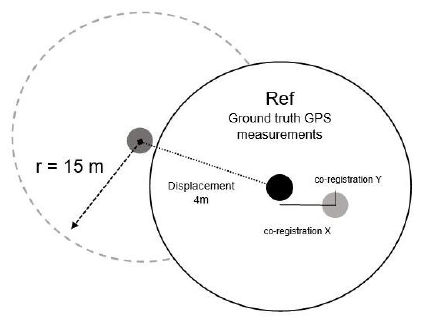
Figure 4. Diagram of the simulated co-registration error by altering the x (easting) and y (northing) coordinates of the measured sample plot positions ( Ref ). The case of a 4 m simulated positioning error is presented.